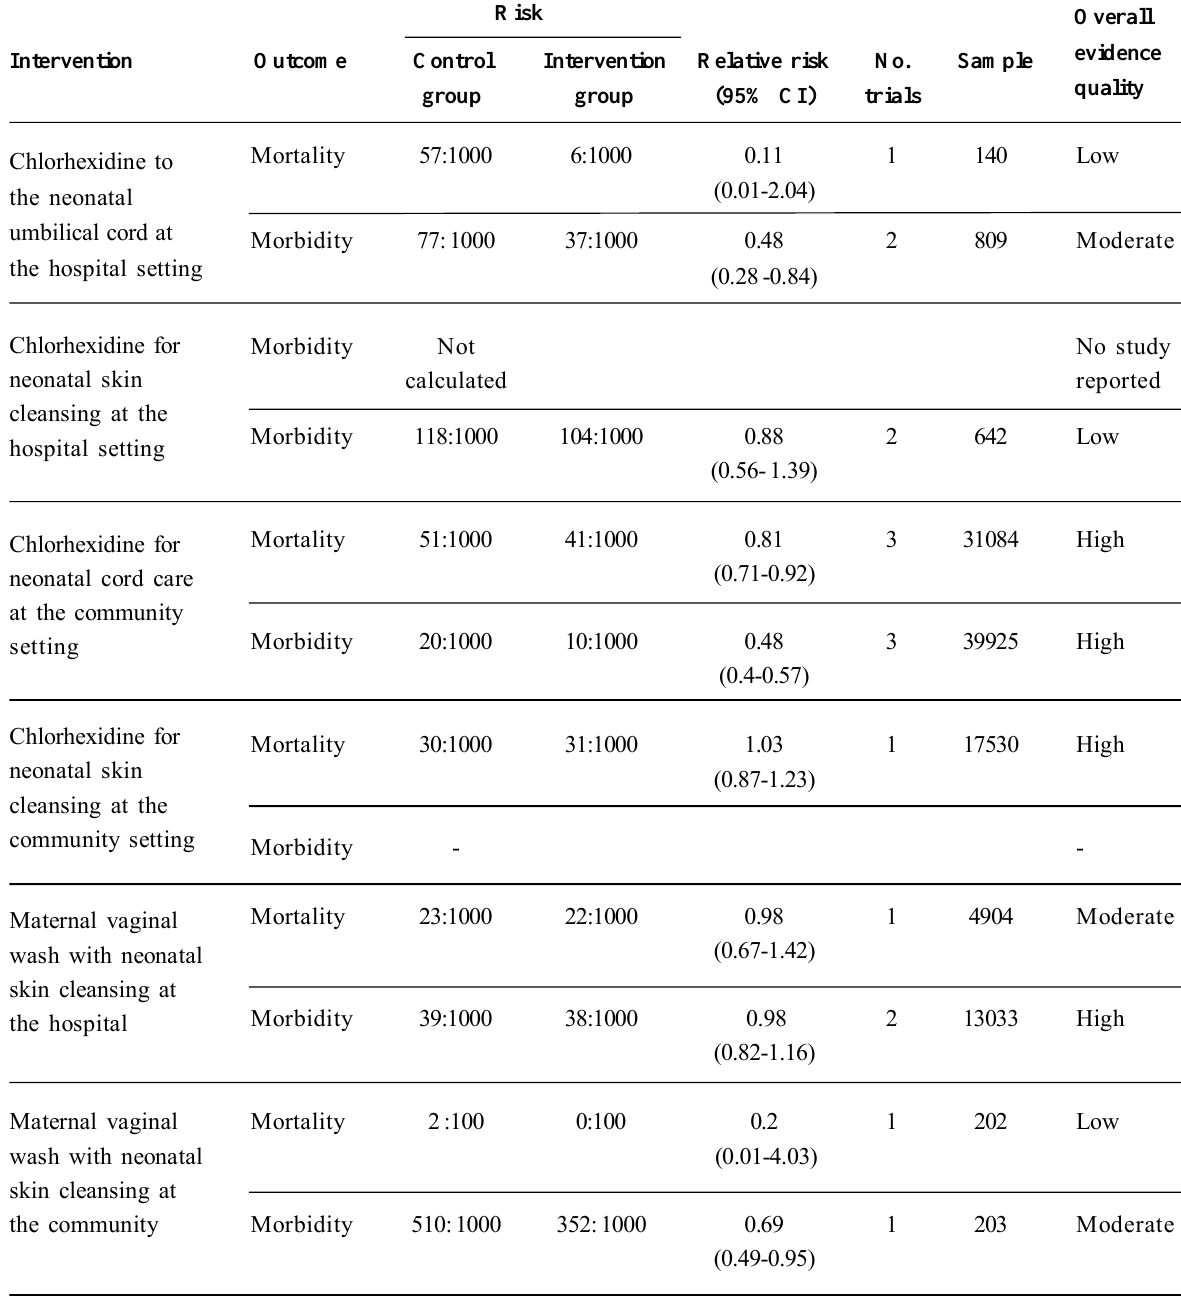
Table 1. Results generated for the six interventions in the Cochrane review and their respective